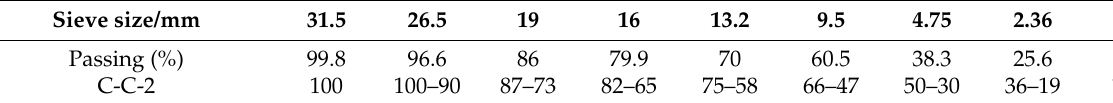
Figure 13. Grading curve of coal gangue.